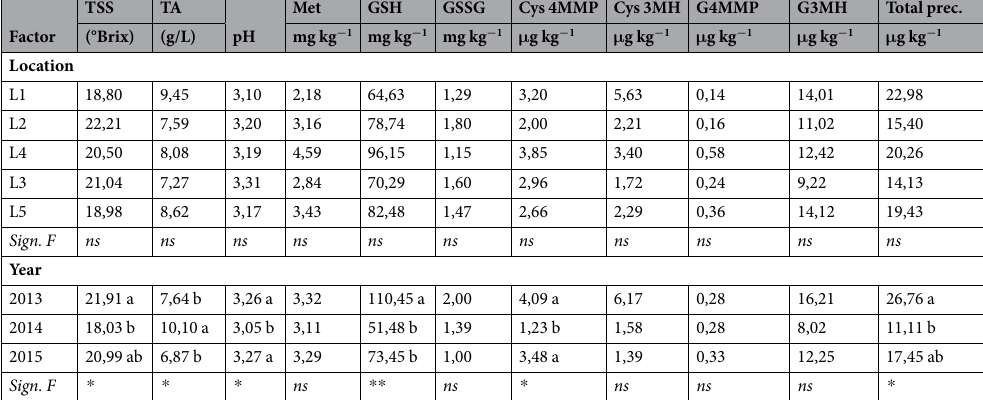
preserve the metabolite levels present at the time of sampling. The possibility of direct evaluation of thiol precur- sors, methionine, glutathione and oxidized glutathione after just one extraction step offers a fast and more precise analytical approach, by avoiding complex sample preparation steps. As regards G4MMP, which was impossible to detect with direct injection, a purification/concentration procedure with deuterated internal standard was used. Sauvignon Blanc grapes were sampled at the time of harvest at five different locations in north-eastern Italy in the period 2013–2015. It was found that the G3MH precursor always dominated in grapes, whereas G4MMP was always less abundant. Cys3MH was the second most abundant precursor, followed by Cys4MMP in 2013 and 2014, whereas in 2015 Cys4MMP was more abundant than Cys3MH. The average content and relative propor- tions of the individual precursors changed in different years.